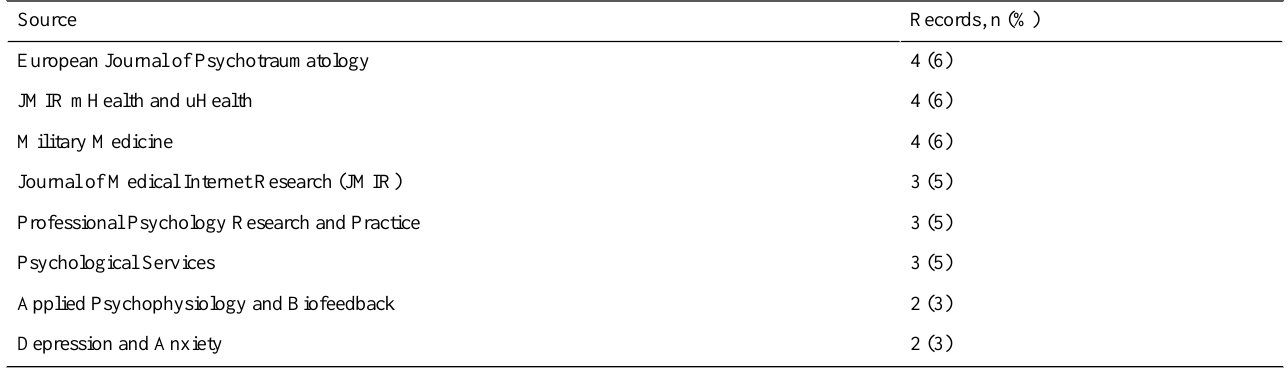
Table 6. Most relevant top publication sources